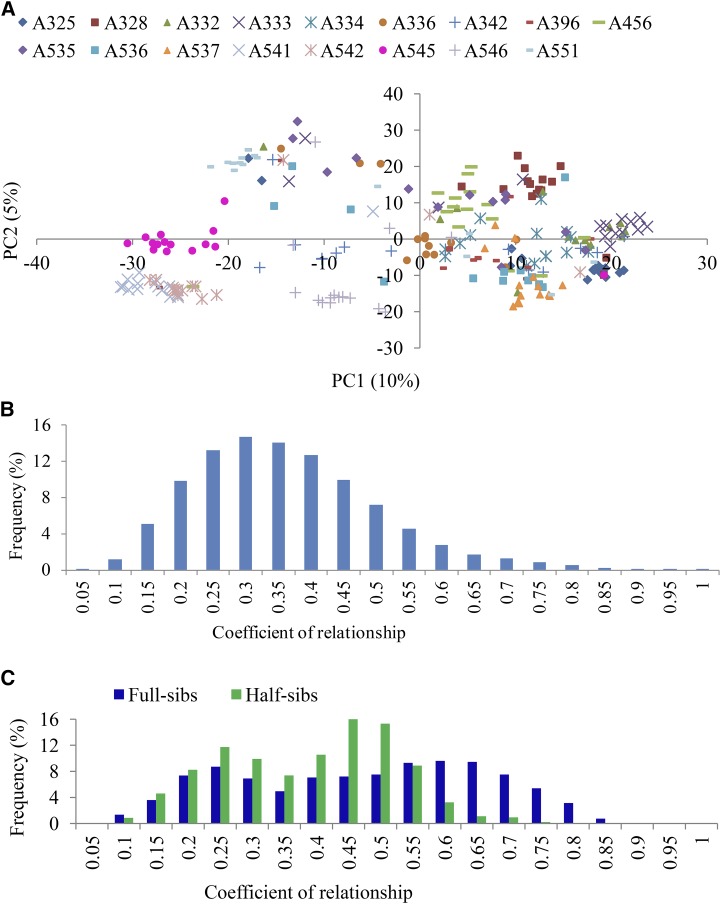
Principal coordinates (PC) plot of all 247 individuals in the apple (Malus × domestica Borkh.) families tested, derived from their marker genotypes (A). Pedigree-based grouping (i.e., full-sib families) is also depicted in different marker colors/shape (A). Distribution of the single nucleotide polymorphism (SNP)-based coefficients of relationships between all pairs of 247 individuals (B), and for pairs of half-sibs and full-sibs is also shown (C).